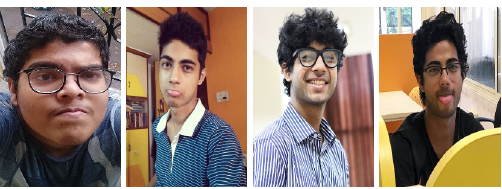
Figure 5. Examples from collected FRGC database